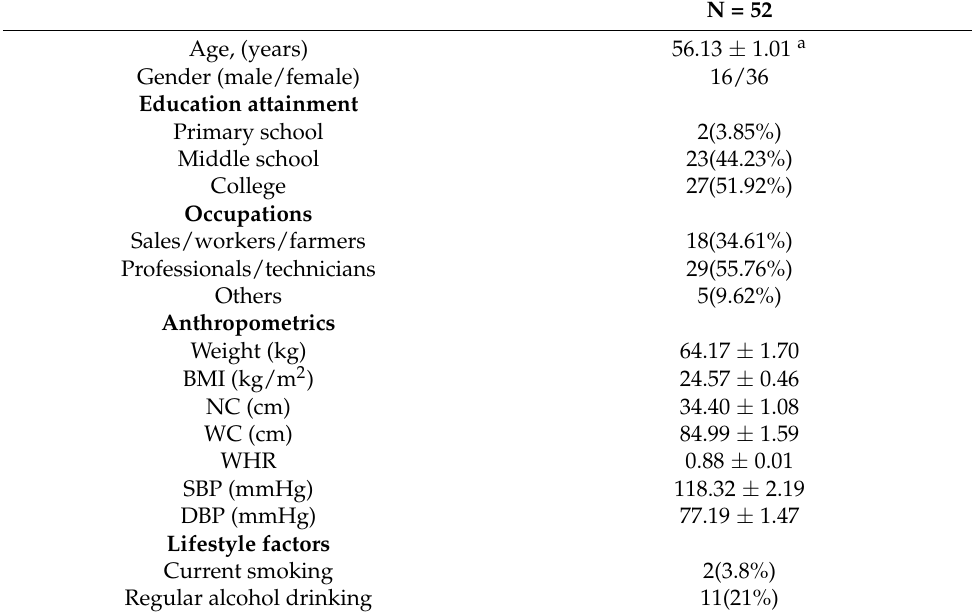
Table 1. Baseline